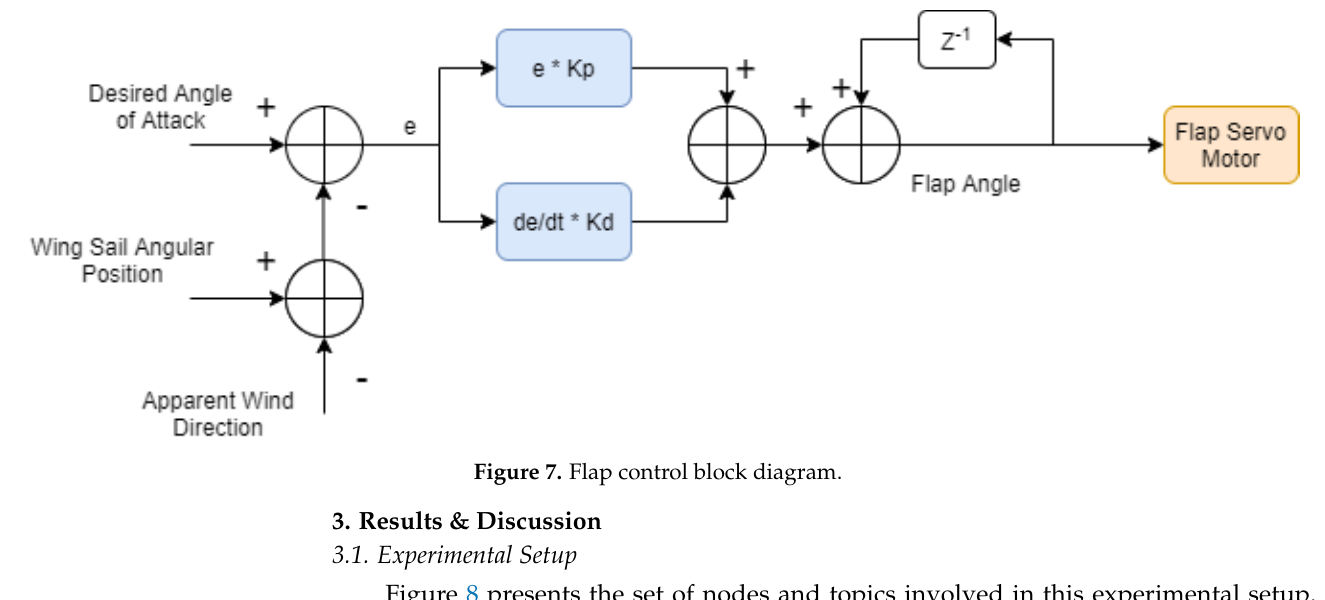
Figure 7. Flap control block diagram.